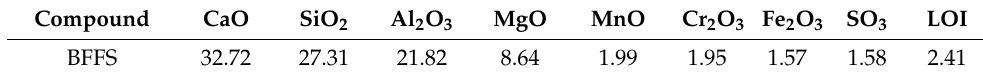
Table 1. Chemical composition of raw materials (wt.%).